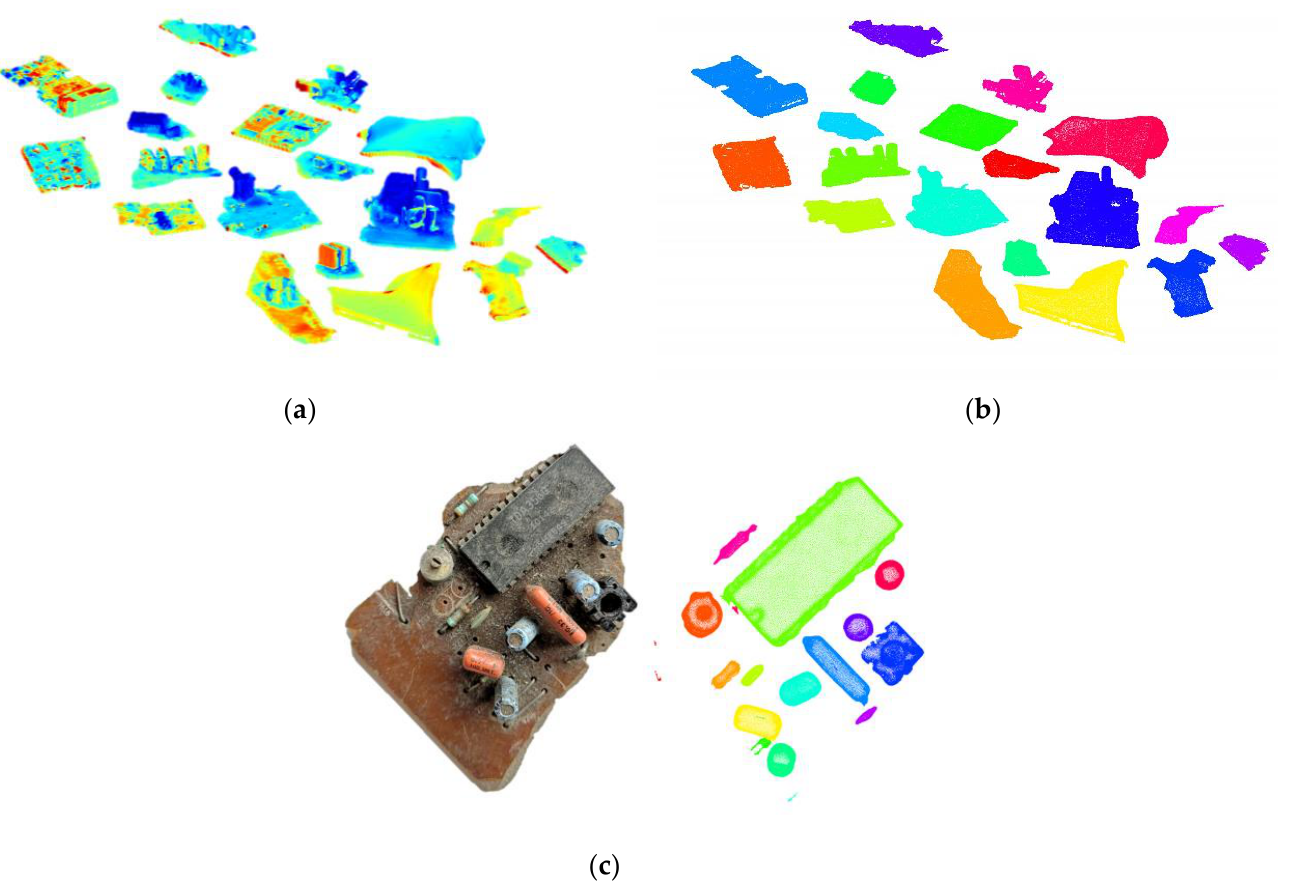
Figure 6. Examples of results of 3D point cloud clustering: ( a ) Background removed dataset; ( b ) Clustered objects; ( c ) PCB with electronic components and clustering result. The clustering is completed after removing the board points using a plane estimation method.